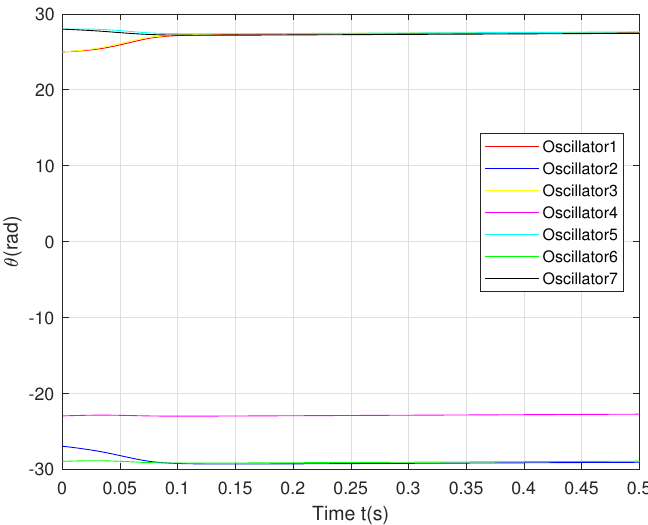
Figure 2. The trajectory of the solution to system (1) without the controller and the stochastic